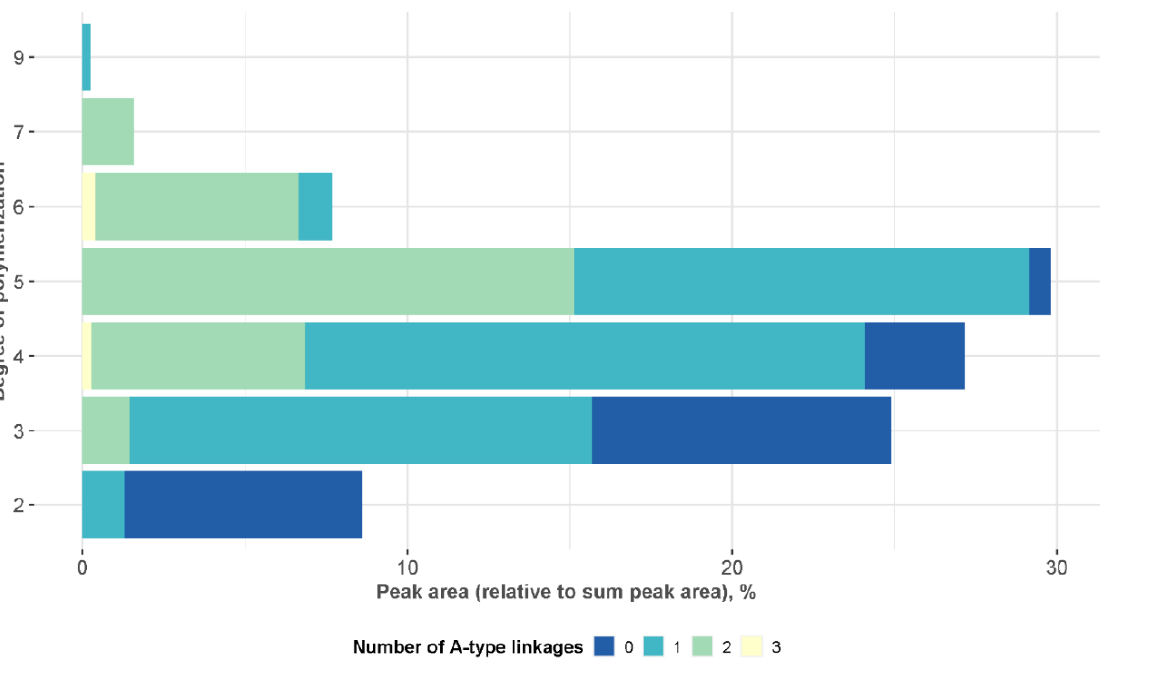
Figure 6. LC-HRMS peak area profiles of procyanidin oligomers found in Vaccinium macrocarpon extract, expressed as a percentage of the total peak area. Table 4. Retention times, full-MS features and putative identities of the detected procyanidin oligo- mers in the purified Vaccinium macrocarpon procyanidin rich fraction. RT — retention time; (E)C —